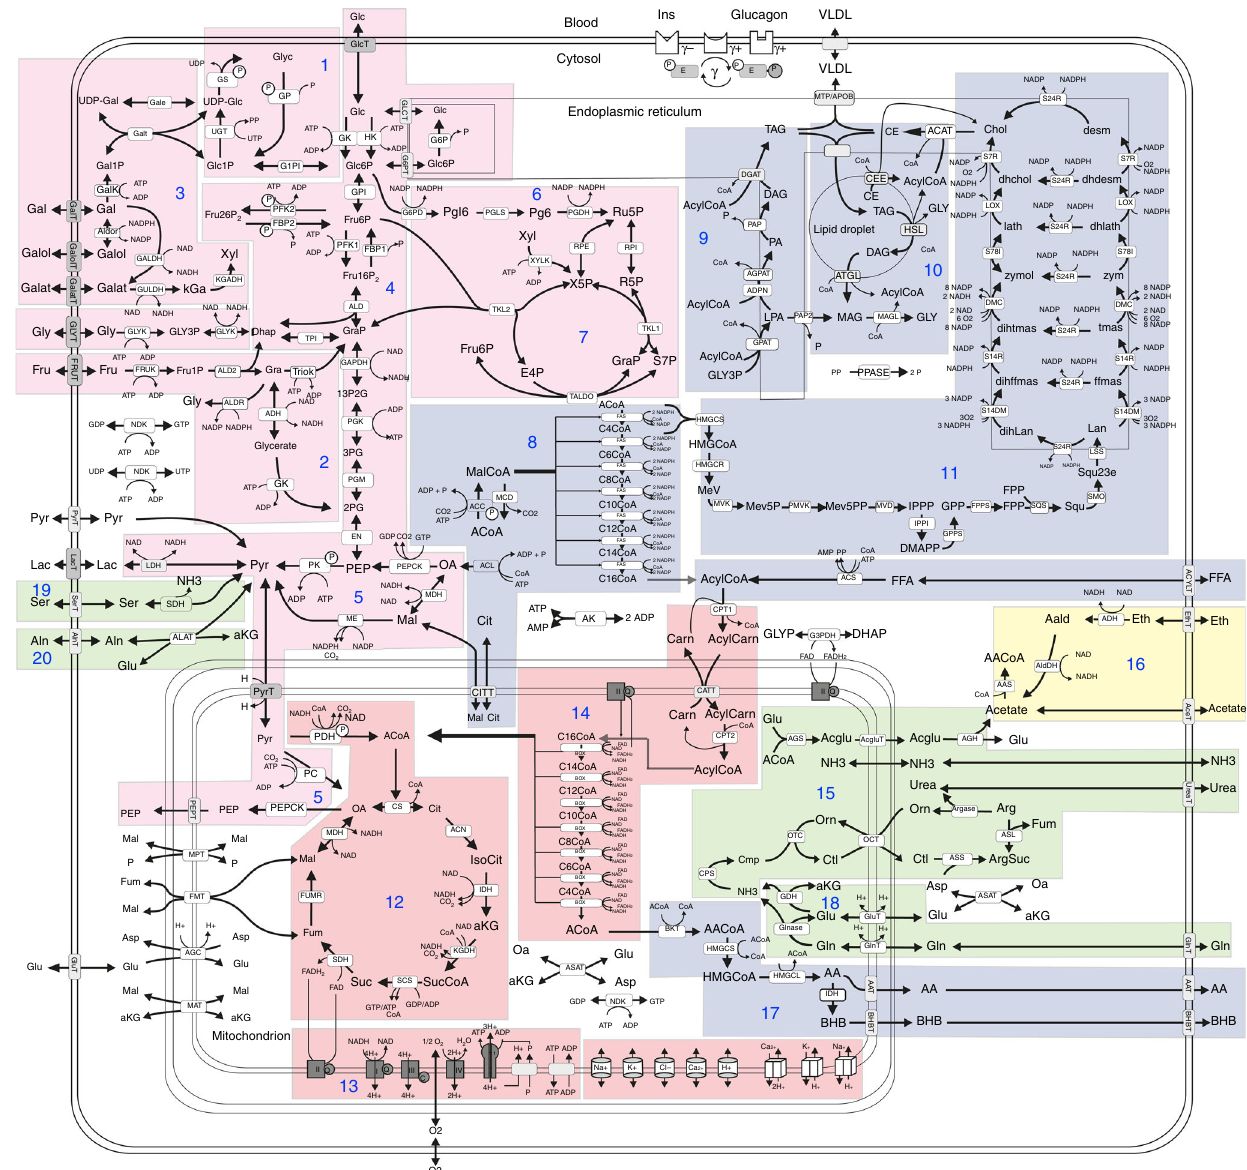
Fig. 1 Reaction scheme of the metabolic sub-model. Reactions and transport processes between compartments are symbolized by arrows. Single pathways as de fi ned in biochemical text books are numbered and highlighted by different coloring: (1) glycogen metabolism, (2) fructose metabolism, (3) galactose metabolism, (4) glycolysis, (5) gluconeogenesis, (6) oxidative pentose phosphate pathway, (7) non-oxidative pentose phosphate pathway, (8) fatty acid synthesis, (9) triglyceride synthesis, (10) synthesis and degradation of lipid droplets and synthesis of VLDL lipoprotein, (11) cholesterol synthesis, (12) tricarbonic acid (TCA) cycle, (13) respiratory chain & oxidative phosphorylation, (14) β -oxidation of fatty acids, (15) urea cycle, (16) ethanol metabolism, (17) ketone body synthesis, (18) ammonia formation, (19) serine utilization, and (20) alanine utilization. Small cylinders and cubes symbolize ion channels and ion transporters. Double-arrows indicate reversible reactions, which may proceed in both directions according to the value of the thermodynamic equilibrium constant and cellular concentrations of their reactants. Reactions are labeled by the short names of the catalyzing enzyme or membrane transporter given in the small boxes attached to the reactions arrow. Metabolites are denoted by their short names. Full names and kinetic rate laws of reaction rates are outlined in Supplementary Note 1. The full names of metabolites and a comparison of experimentally determined and calculated cellular metabolite concentrations is given in Supplementary Data